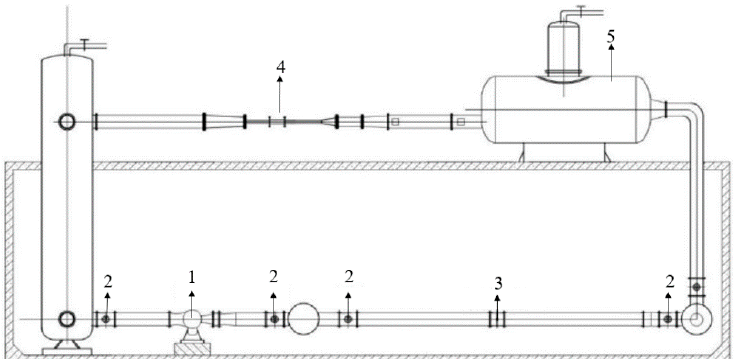
Figure 4. Schematic diagram of the experiment bench system. (1) Circulation pump, (2) gate, (3) electromagnetic flowmeter, (4) observation section, (5) vacuum tank.